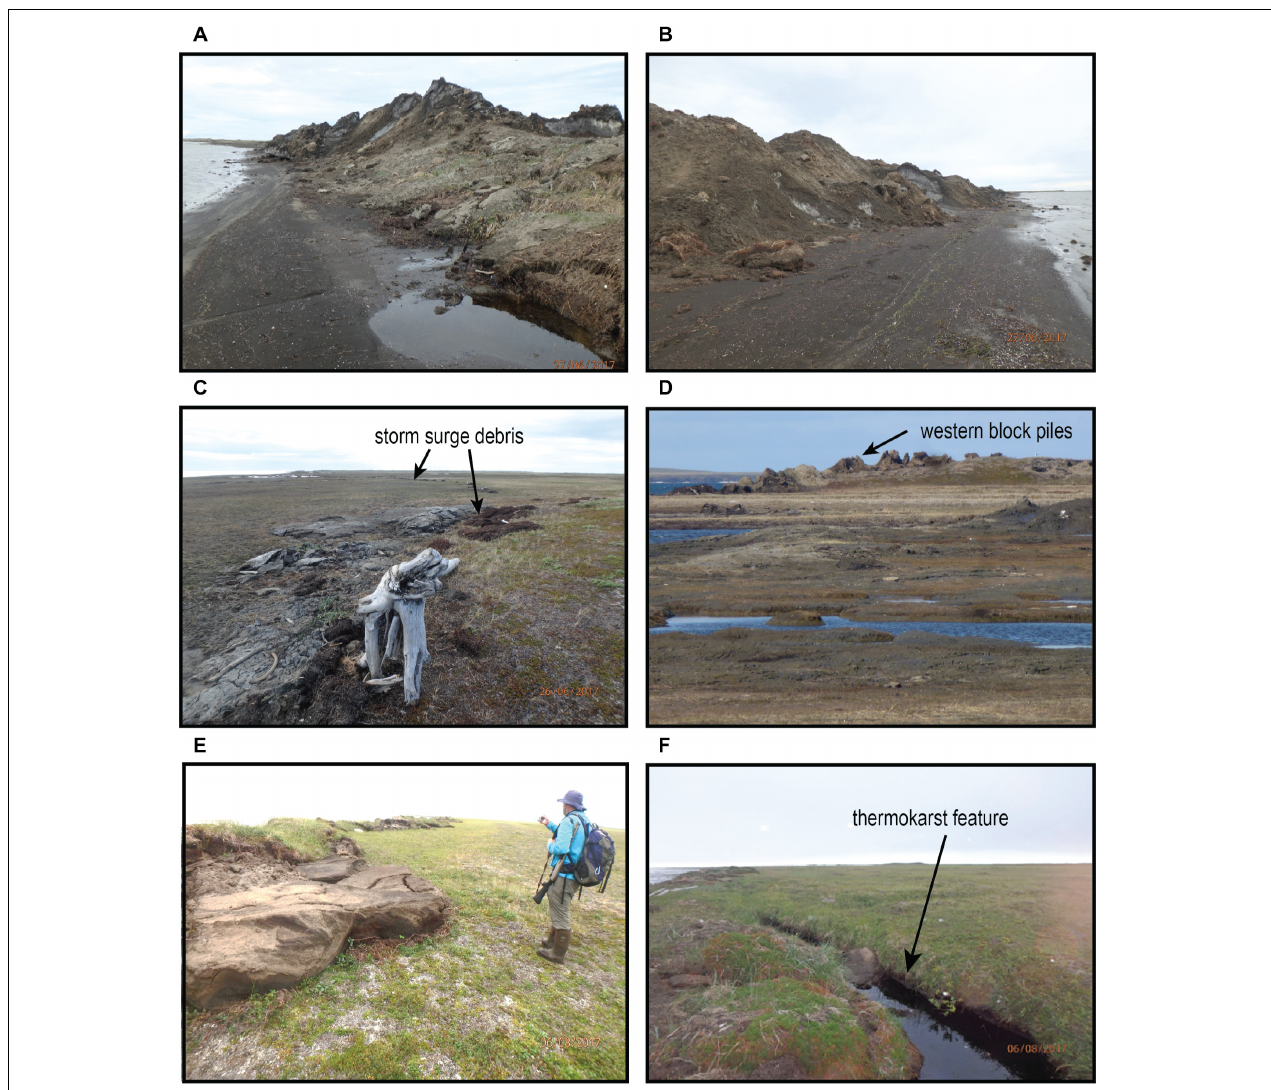
FIGURE 11 | Photographs of ivu impacts along the eastern, central, and western portions of Cape Espenberg ( Figure 3 ). (A) Photo taken from the foreshore looking east with small erosional scarp and large ice pile-up debris. (B) Looking west toward the tip of the cape with ice blocks and eroded sediments shown. (C) Storm surge debris line in central low-lying area adjacent to archeological site. (D) Photo looking east across central low-lying swale with large piles of sediment blocks along western coastline. (E) Along this western portion of the coastline, large blocks of bluff material were cast landwards. (F) Parallel to the impacted western coastline, 20–50 m longshore parallel thermoerosional cracks were observed filled with water and ivu